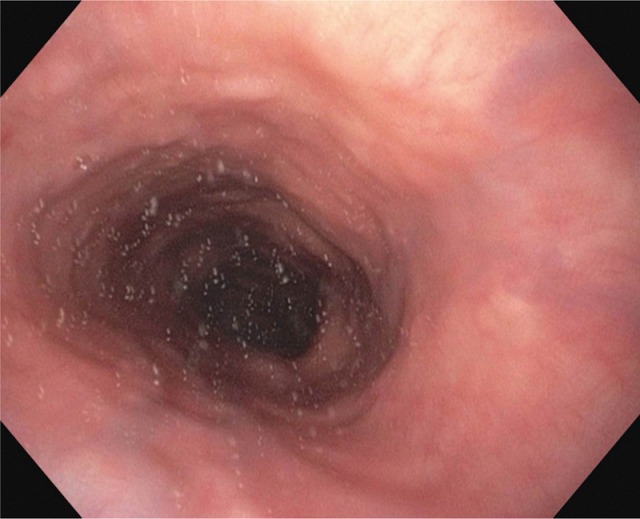
Middle esophagus: particles are visible under gas pressure and “fly” through the open esophageal lumen due to a pressure gradient (gas reflux)